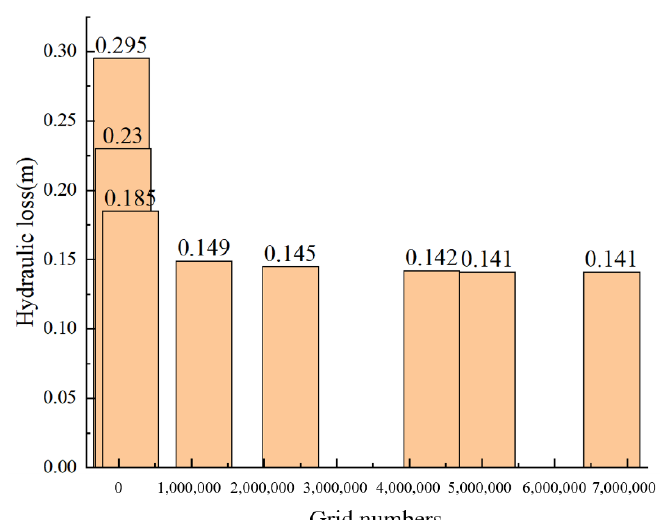
Figure 3. Hydraulic losses under different grid numbers.